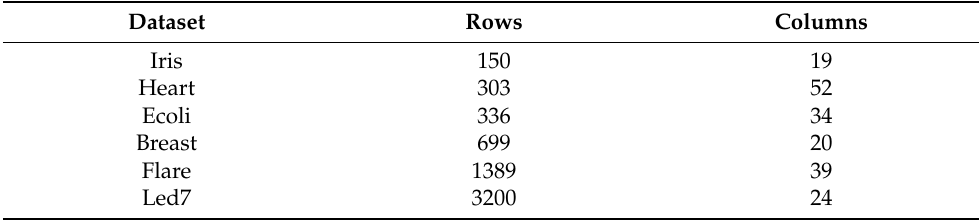
Table 2. Dataset